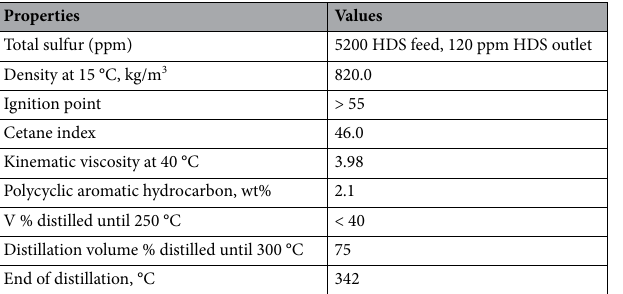
Table 1. Physical and chemical properties of a typical diesel fuel obtained from refinery X, South